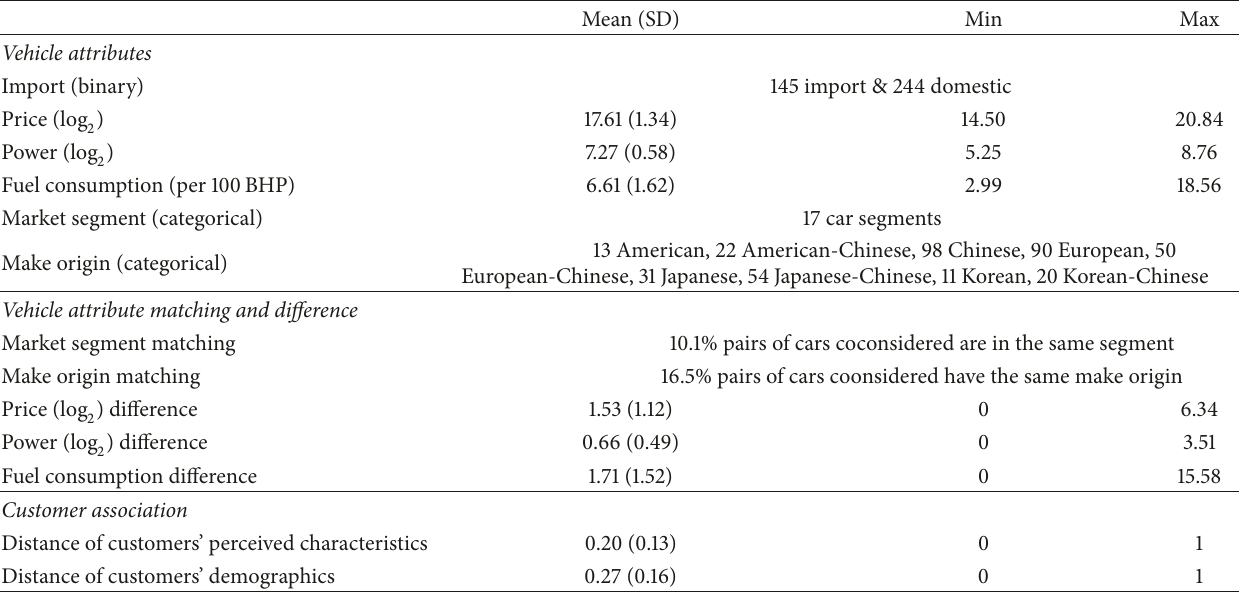
Table 3: Descriptive statistics of independent variables for 389 car models in